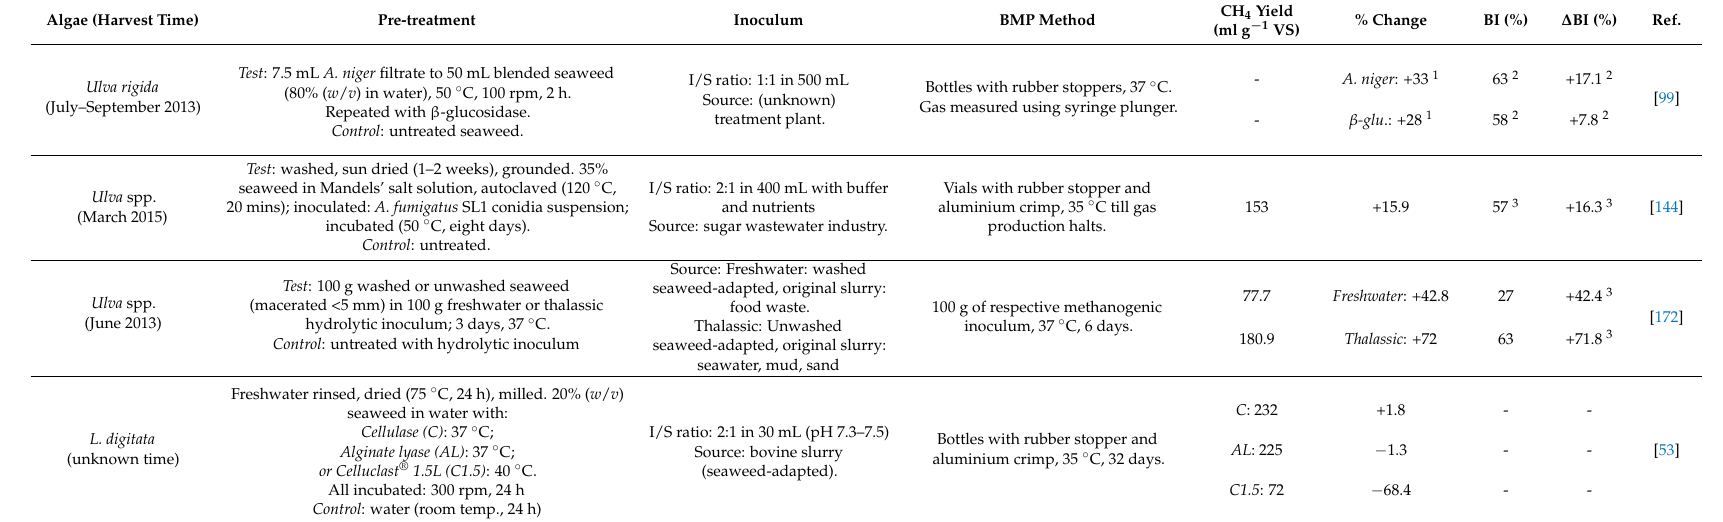
Table 7. Methane yield following biological pre-treatment of seaweed.